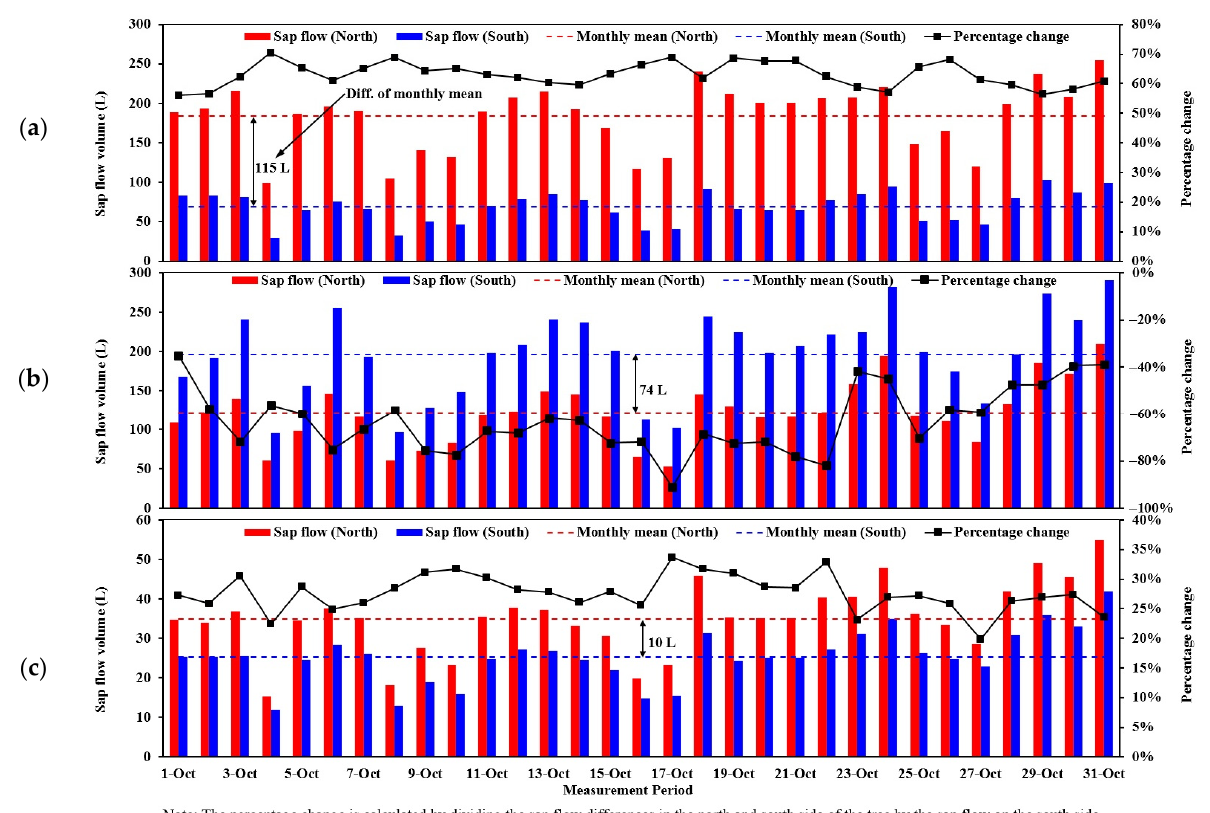
Figure 10. Comparison of daily sap flow volume at north and south sides of each of the three species ( a ) C. maculata ( b ) M. styphelioides ( c ) L. confertus .